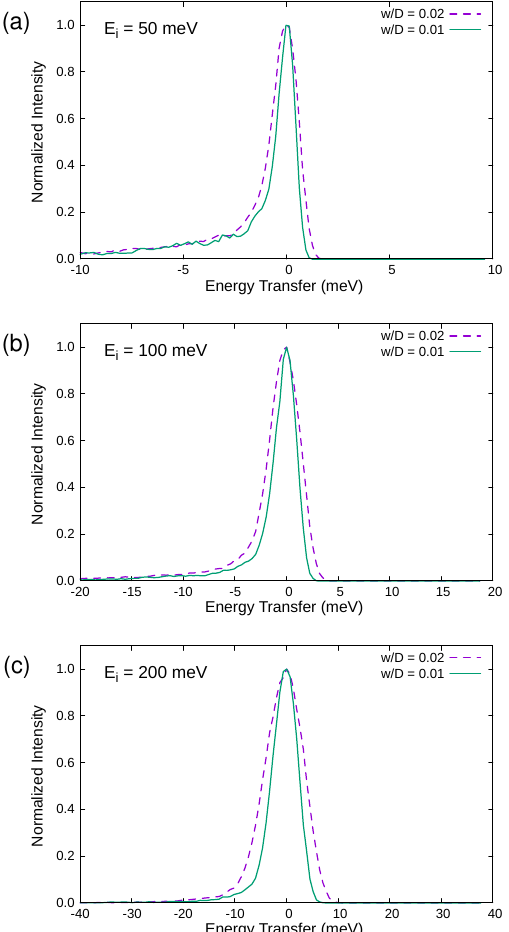
Figure 3. Energy-transfer spectra for w/ D = 0 . 02 (broken lines) and 0.01 (solid lines) obtained by Monte Carlo simulations for (a) E i = 50meV, (b) 100meV, and (c) 200meV. The Fermi chopper with D = 20mm is rotated at 600 Hz. The sample is a 1-mm thick hollow cylindrical vanadium that is 20mm in diameter and 20mm in height. The peak intensities are normalized to